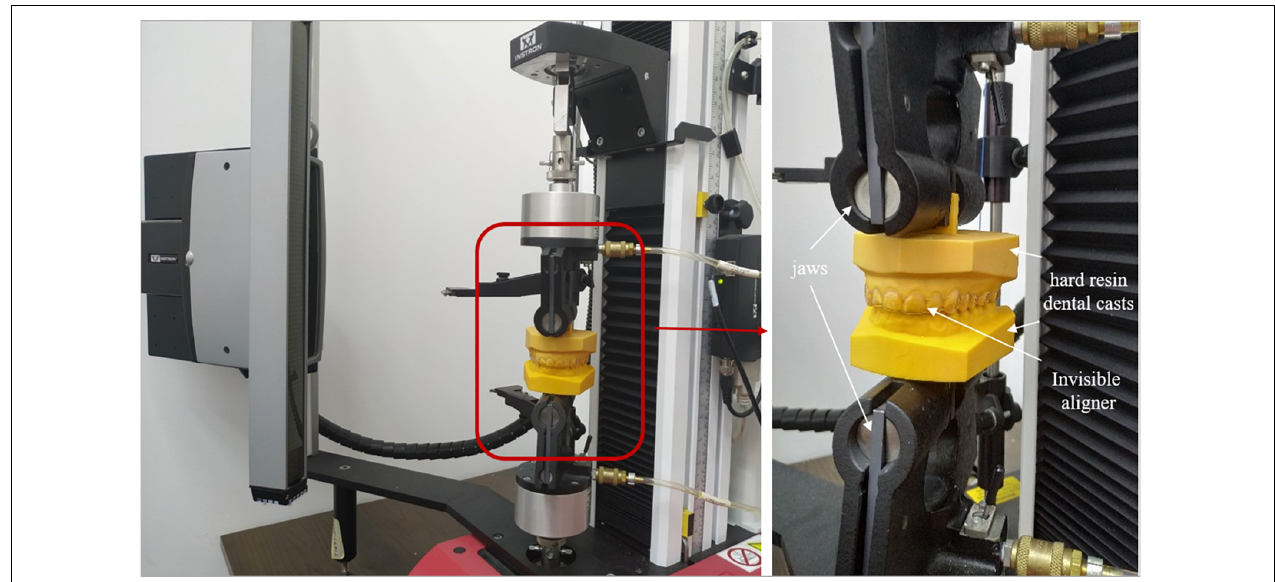
FIGURE 2 | Setup for the cyclic compression testing.